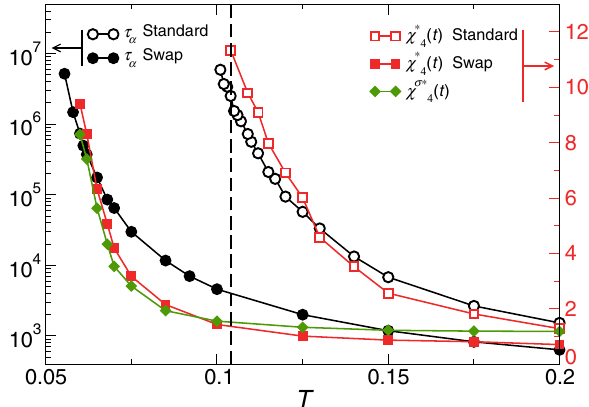
FIG. 14. Temperature evolution of dynamic susceptibilities (right axis) and relaxation times (left axis). The vertical dashed ¼ 0 . 104 . Whereas χ d ð t Þ grows together with τ line is T α in 4 MCT standard simulations, χ d 4 ð t Þ and χ σ 4 ð t Þ behave similarly and have a very different temperature dependence which instead mirrors the evolution of the swap relaxation